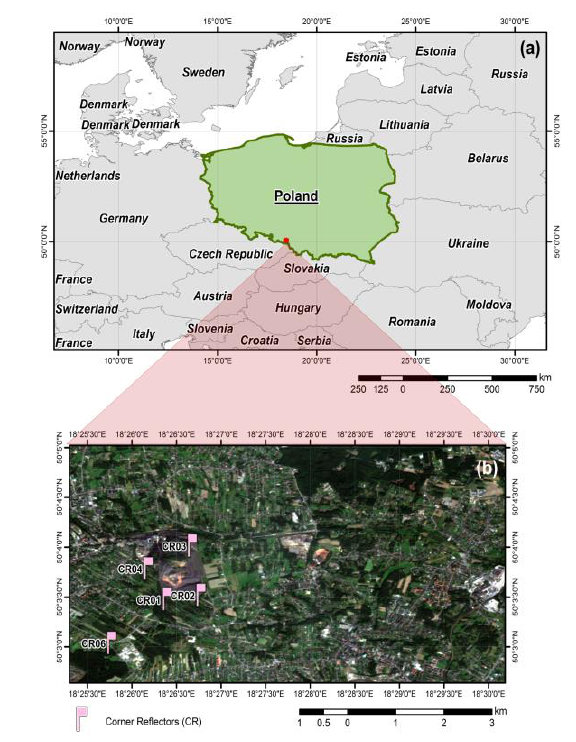
Figure 1. Location of the area of interest on the Europe country map (a) and Rydułtowy mine with CRs based on satellite